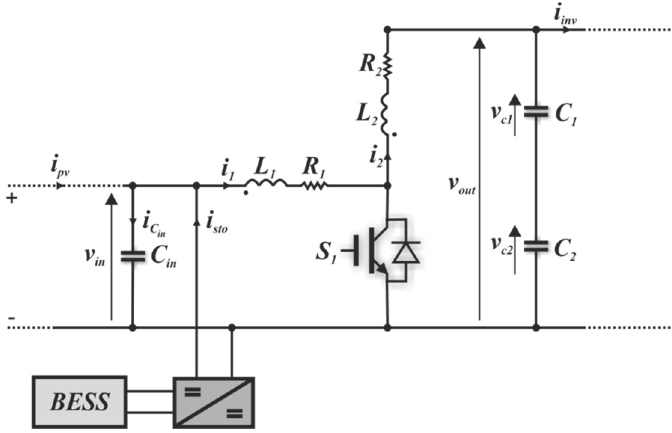
Figure 3. First power stage with coupled-inductors and BESS .